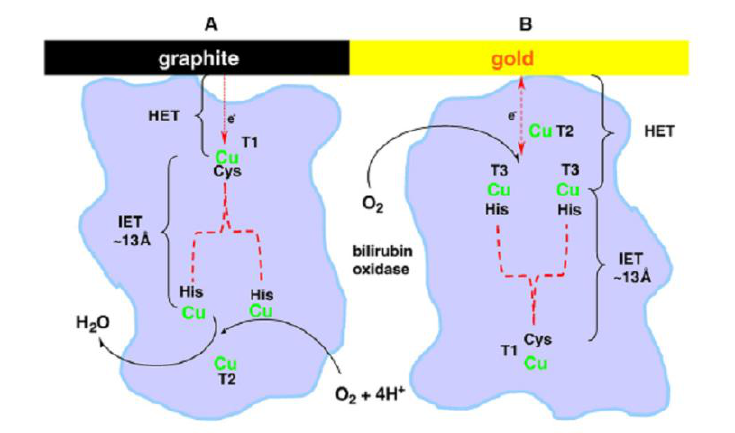
Figure 7. Schematic presentation of proposed mechanisms of DET from electrodes to BOD connected (A) via the T1 site and (B) via the T2/T3 cluster. Reprinted from [35] with permission from